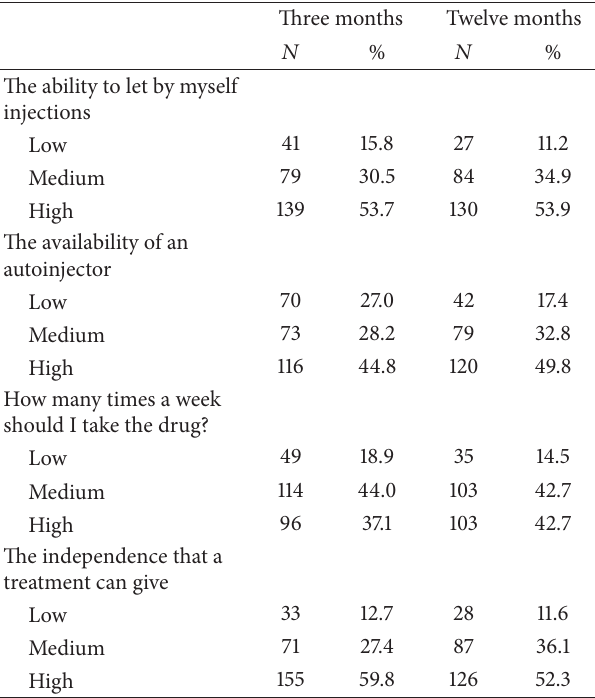
Table 7: Cause of change in the number or dosage of injections.